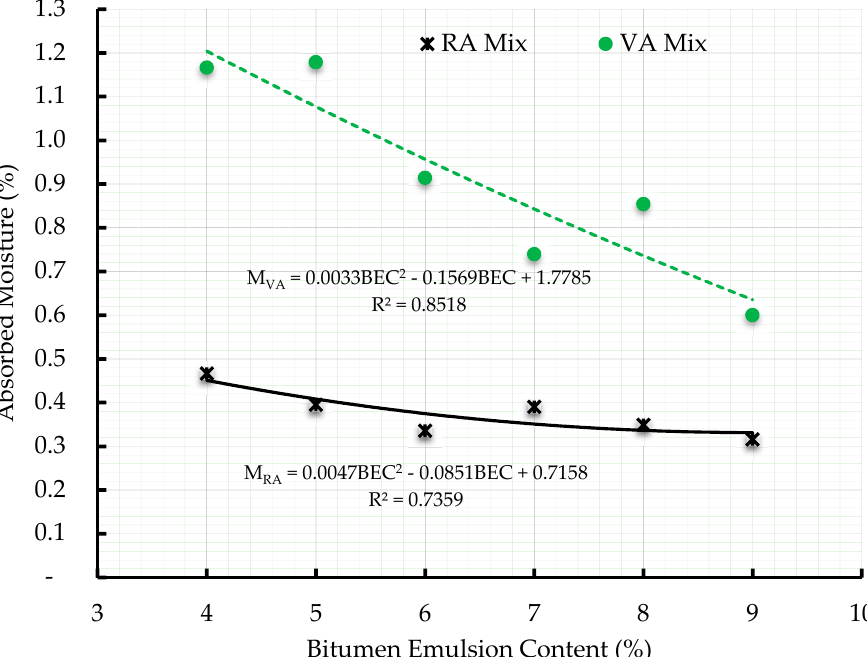
Figure 8. Moisture absorption for Virgin Aggregates and Reclaimed Asphalt Aggregates Mixes at Optimum Bitumen Emulsion Contents.